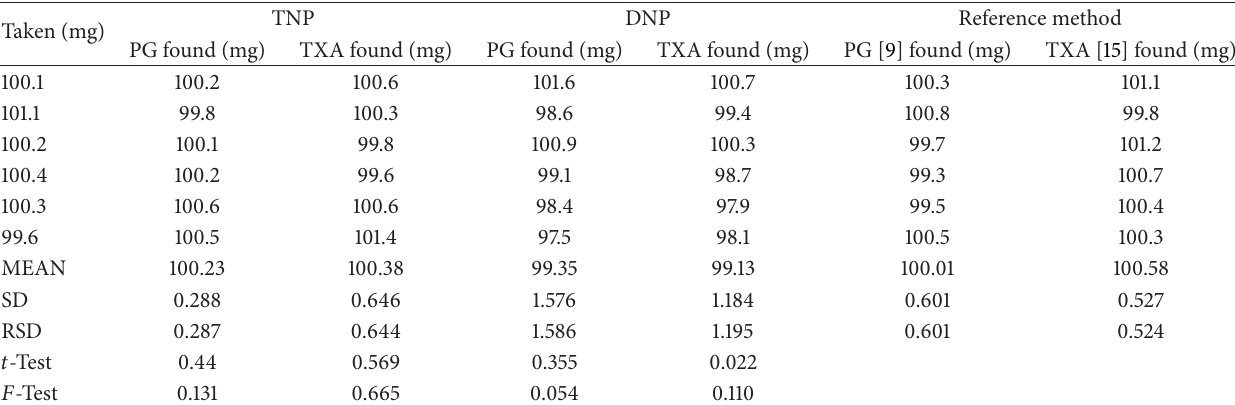
Table 5: 𝐹 and 𝑡 tests of the